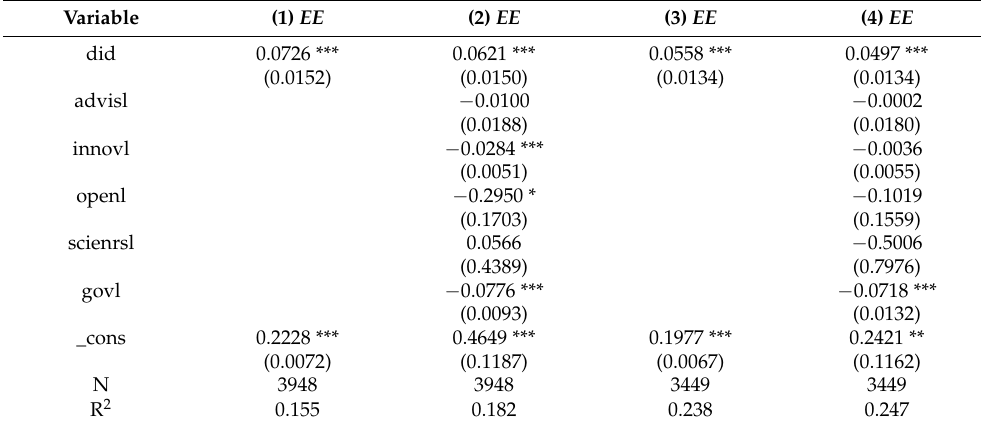
Table 4. Benchmark regression